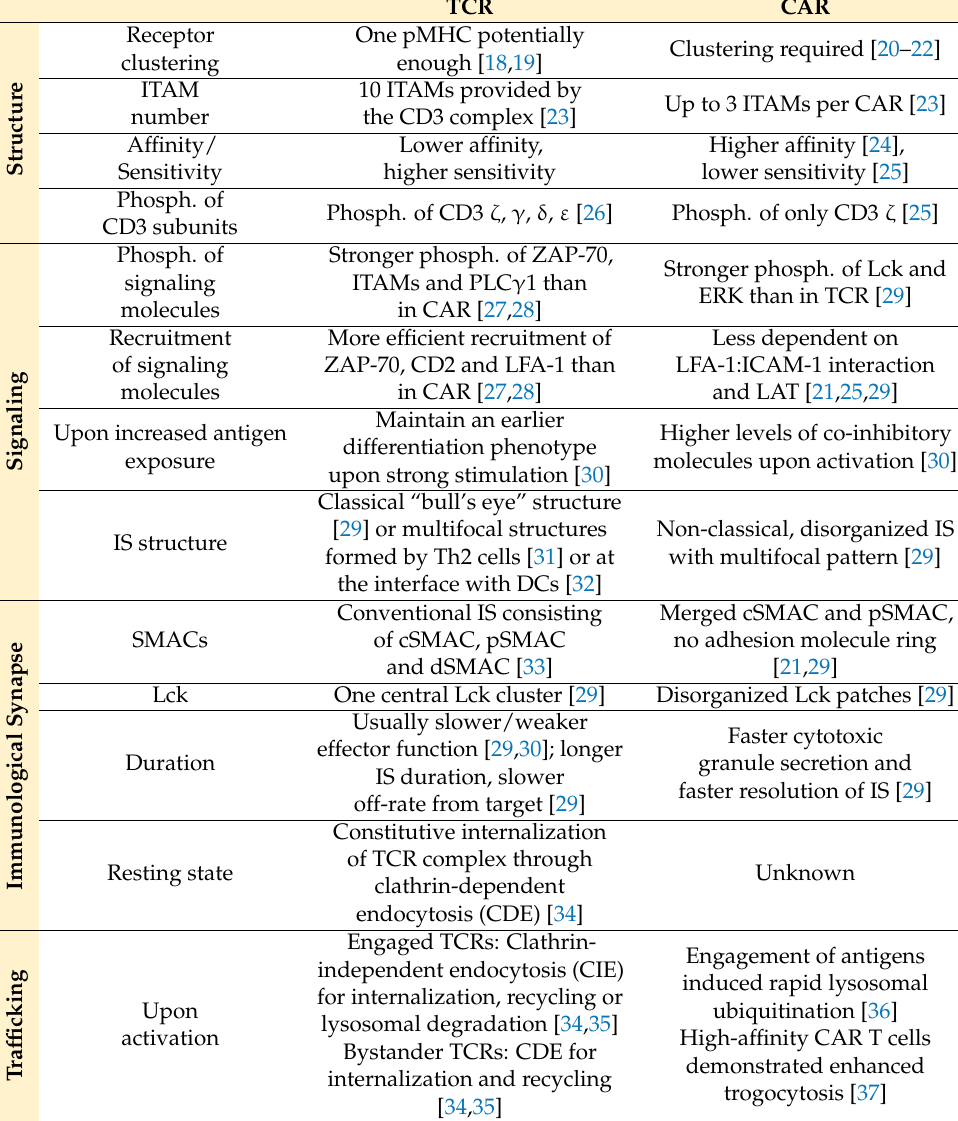
Table 1. Summary of similarities and differences between TCR and